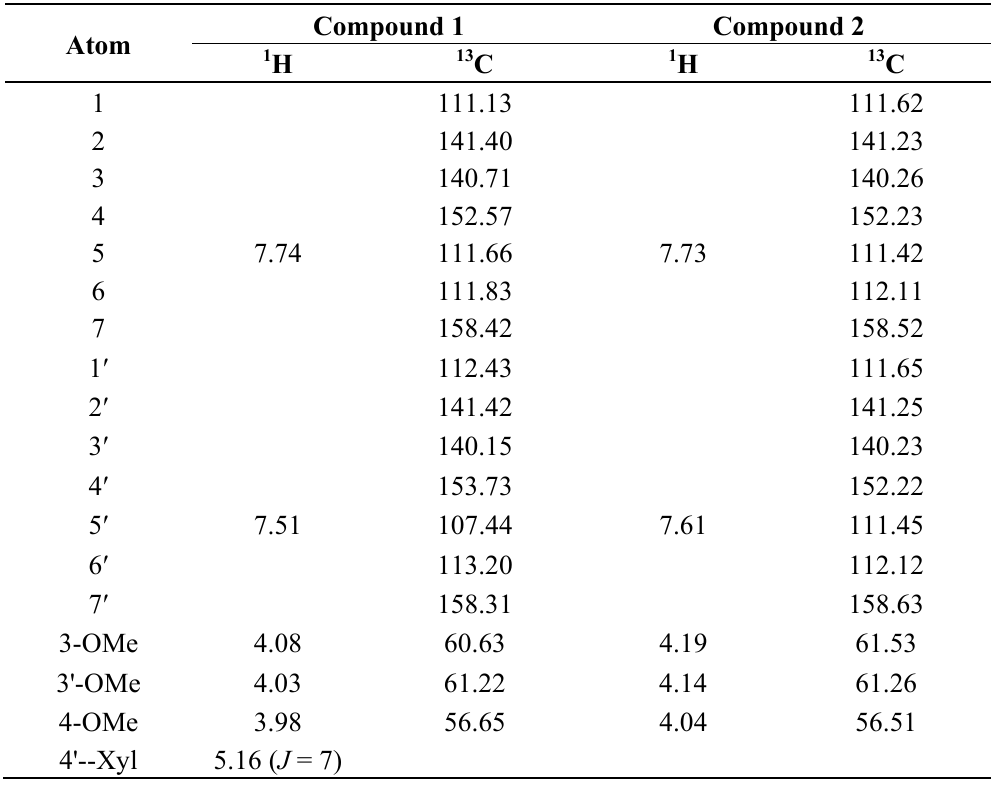
Table 1. NMR Spectra of Compounds 1 – 2 [600 and 160 MHz, DMSO- d